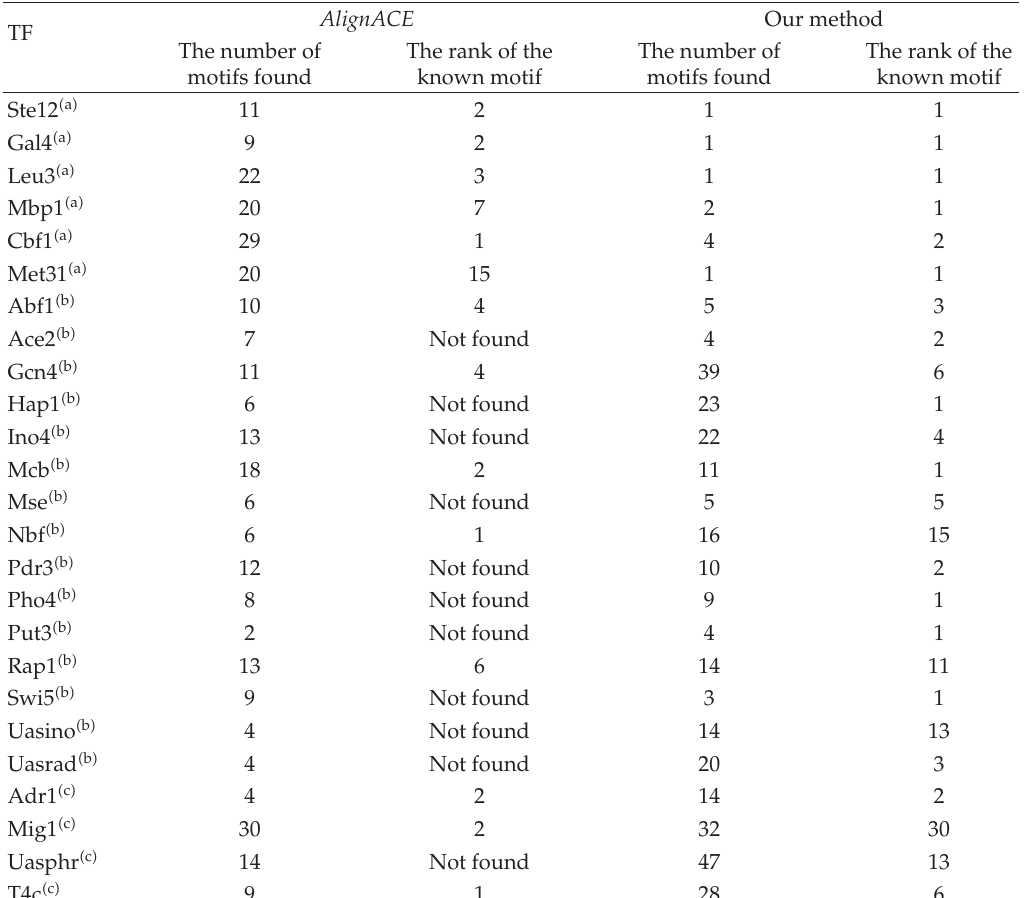
Table 3: Comparison to AlignACE . For each TF, we listed the rank of the known motif in the predictions. Three di ff erent parameter threshold settings, namely, (cid:2) a (cid:3) , (cid:2) b (cid:3) , and (cid:2) c (cid:3) , are used in our method as given in Table 2.